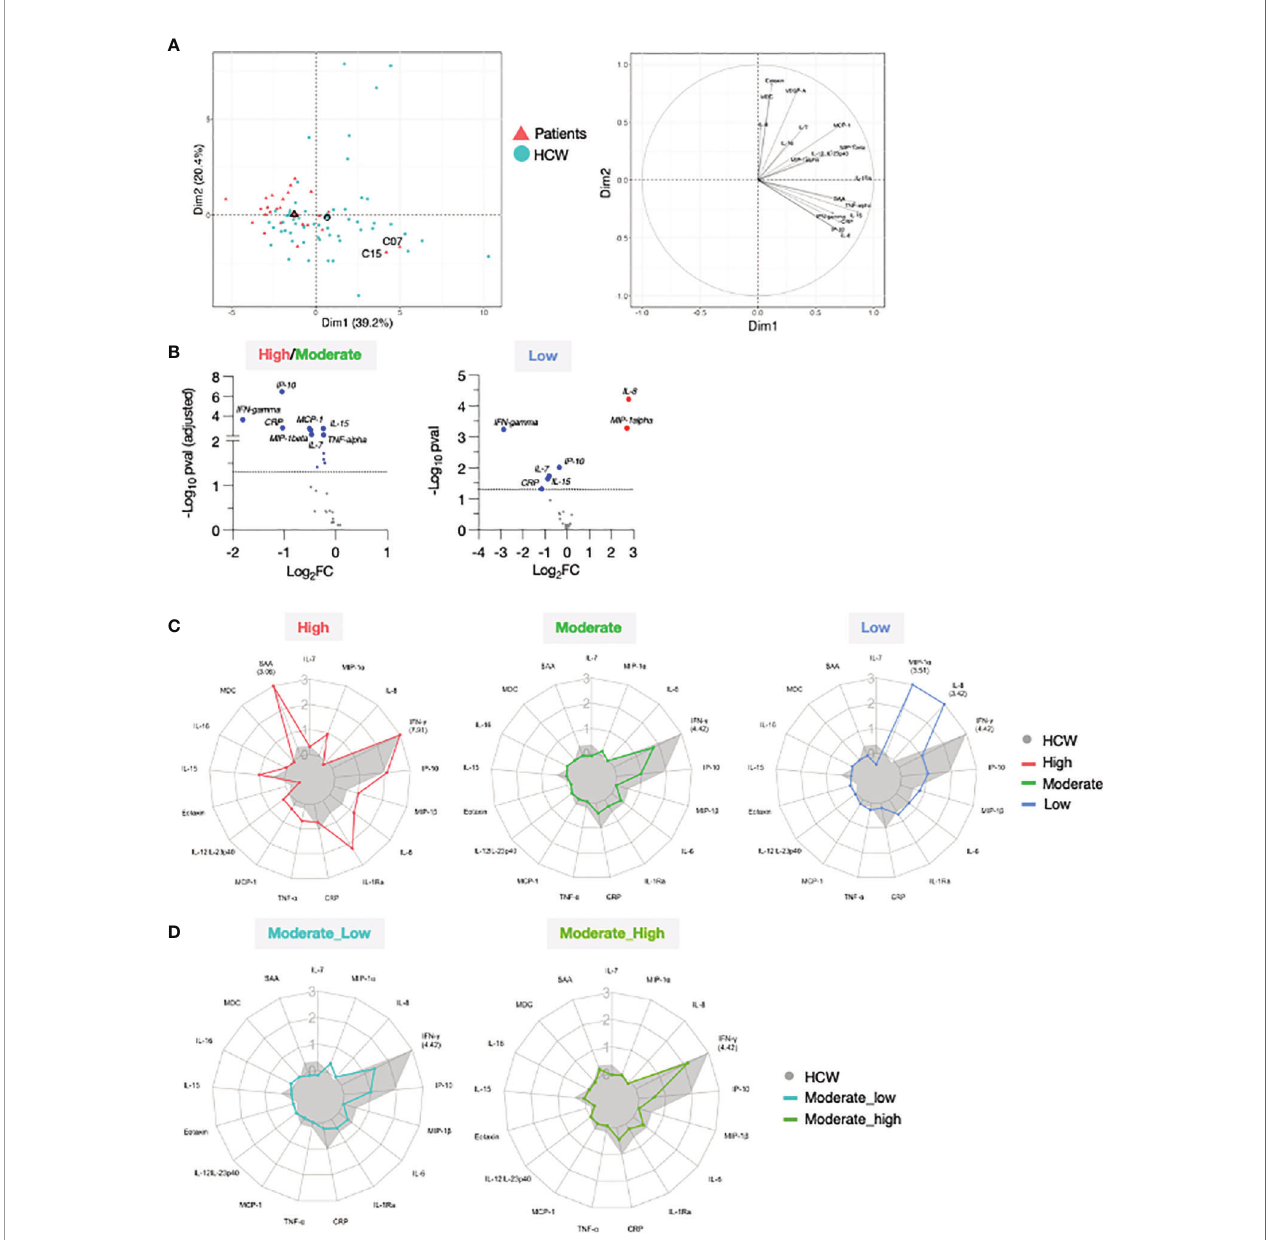
FIGURE 6 | Comparison of serum cytokine and chemokine pro fi le after 2 nd vaccination in patient and HCW vaccine recipients. (A) PCA plot (left) distinguish patients (red triangle) from healthy volunteers (blue circle) based on the cytokine log2FC at d23 in comparison to d22 (2 nd vaccination effect), capturing 39.2% and 20.4% of the dataset variance along PC1 and PC2, respectively. Median from each group is depicted as larger symbol. PCA loading plot (right) showed how strongly cytokines (depicted as grey vectors) in fl uence both PC1 and PC2. The projection of the vectors on PC1 and PC2 corresponds to the loading value (weight) of the cytokine they represent. (B) Volcano plot depicts differentially regulated analytes after 2 nd vaccination (d23 compared to d22) between 25 patients in the high/moderate responder group and 57 HCW (left panel) and between 4 patients in the low responder group and 57 HCW (right panel). Blue dots indicate cytokines that were signi fi cantly less affected by 2 nd vaccination in patients in comparison to HCW. Signi fi cance was set at an adjusted p value < 0.05 (broken horizontal line) for the high/moderate group. A cut-off p value <0.05 was used for the group of low responders. (C) Radar plots compared the median log2FC for each cytokine after 2 nd vaccination (d23 compared to d22) between HCW (n = 57, fi lled grey area) and patients with high (left panel; red, n = 3), moderate (middle panel; green, n = 22), and low (right panel; blue, n = 4) anti-Spike Ab titers measured at d50. Plot axis is truncated at log2FC=3, with values exceeding this cutoff shown in parentheses (high responders: IFN- g =7.91; SAA=3.06; HCW: IFN- g =4.42). (D) Patients in the moderate group were further separated into moderate_high (n = 8) and moderate_low (n = 14). Radar plot compared the median log2FC for each cytokine after 2 nd vaccination (d23_22) between HCW and patients in the moderate_high and moderate_low